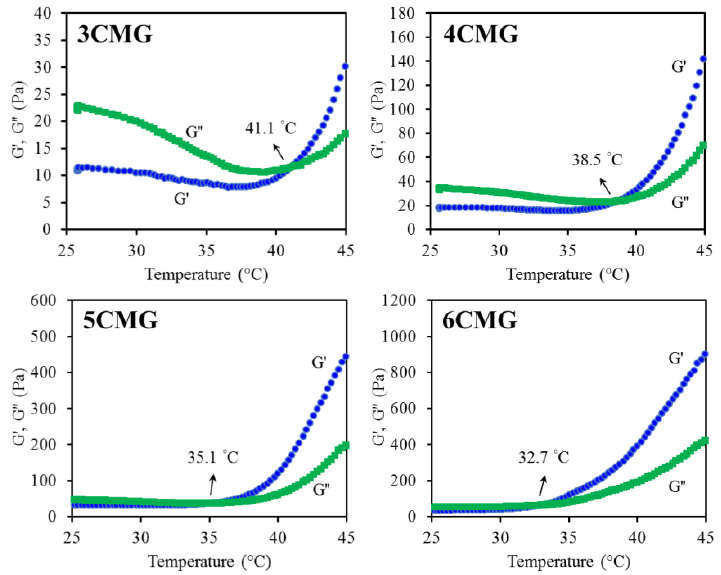
Figure 3. SEM micrographs of various CMG hybrid hydrogels.